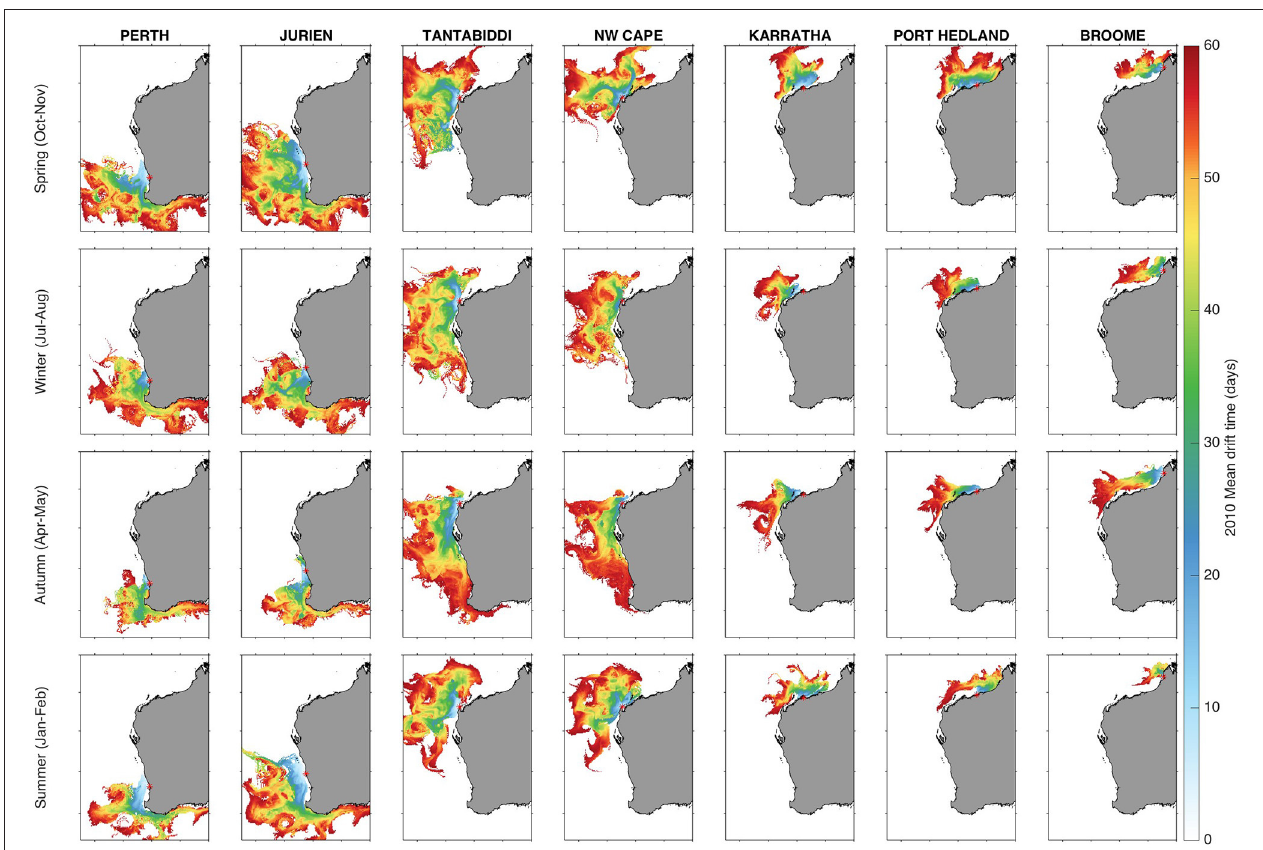
FIGURE 4 | Mean seasonal drift time in days for particles released at seven sites along the Western Australia coast during 2010. Each map shows the mean of ∼ 60,000 individual particle